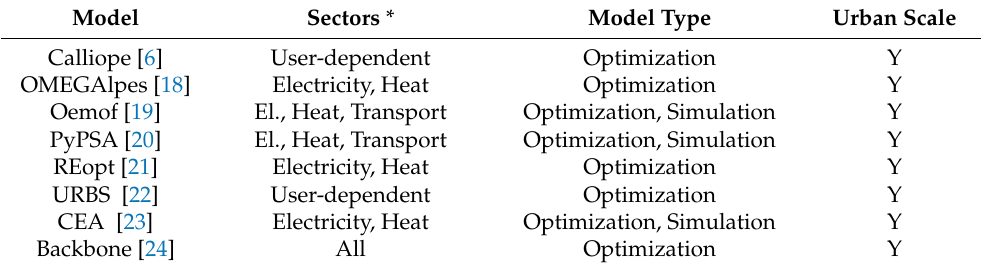
Table 1. List of models that allow modelling of multiple sectors and at the urban scale.